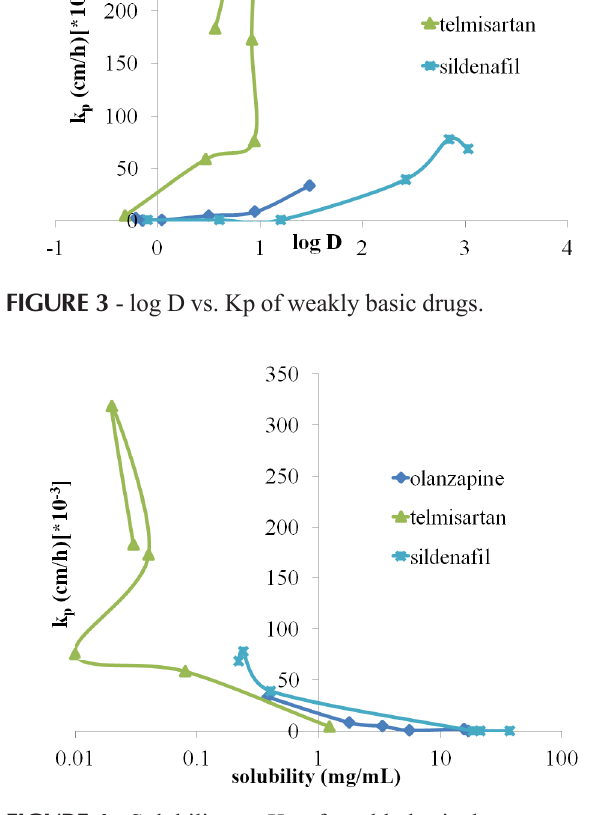
FIGURE 6 - % of unionized drug vs. Kp of weakly basic drugs.